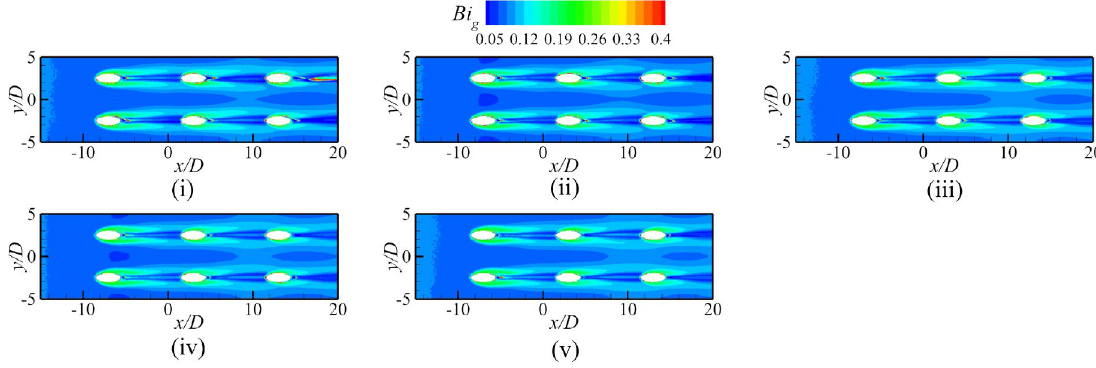
Figure 17. Effects of internal cooling structures on η and Bi g